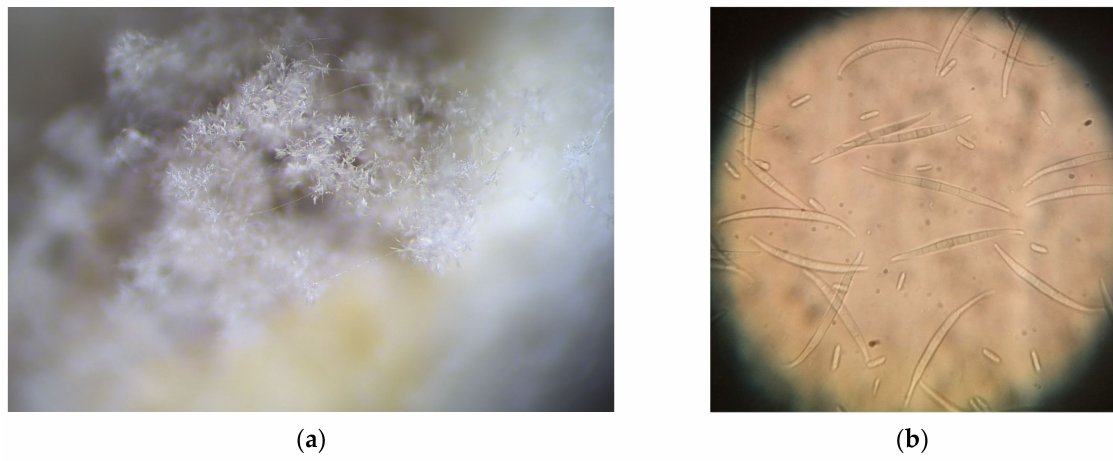
Figure 5. Fusarium spp. on carrot seeds ( a ) and spores ( b